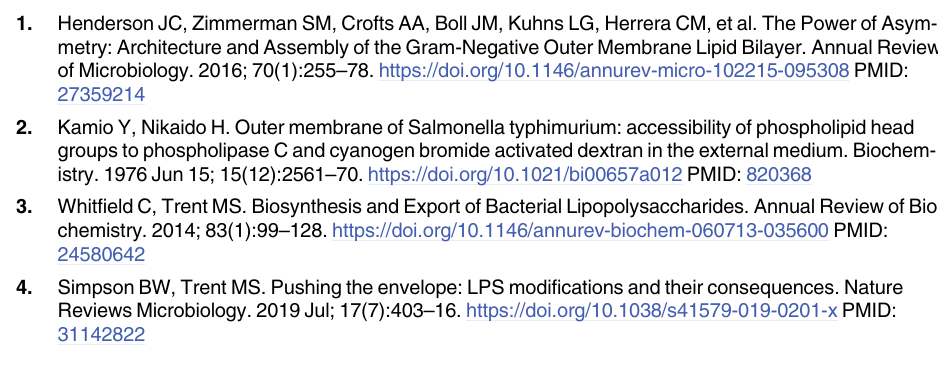
were monitored by OD every hour at 37˚C. After 3 hours of growth, cultures were inocu- 600 lated with 32 P and aliqouts were collected for further analysis. Error bars represent SD from i biological triplicates. (C) Surface area/volume measurements of cells at beginning of 32 P addi- i tion. Cell width and length of listed strains were measured using MicrobeJ software after strains were inoculated with 32 P and imaged at 1000x on agarose pads, S/V was calculated i using cell width and length. T-test used between strains. 0.0001 > P ���� . (D) LPS distribution across OM and OMV. 60 minutes after W3110 and W3110 yhdP , tamB , ydbH/ P :: yhdP ara grown in glucose was inoculated with 32 P , lipid A was extracted from the collected OM and i OMV fractions and lipid A distribution was calculated from TLC densitometry. T-test used between strains. 0.05 > P � . S1 Table. Strains, plasmids and primers used in this